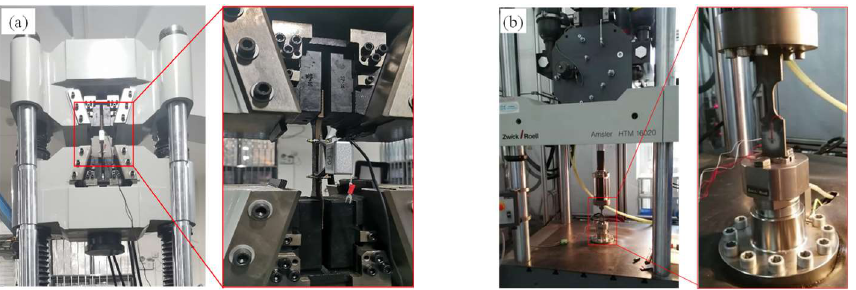
Figure 6. Test machines for unidirectional tensile tests of the material: ( a ) universal tensile test machine for quasistatic tension; ( b ) test machine for dynamic tensile test.